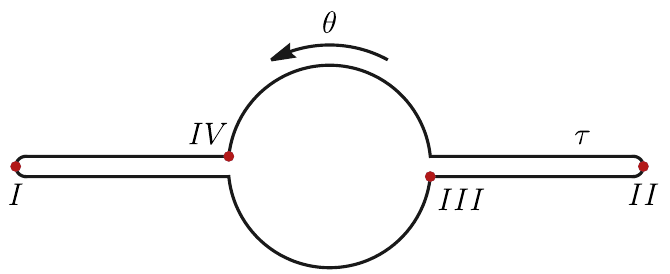
Figure 8 . As explained in [1] the Regge correlator can also be viewed as an OTOC in angular